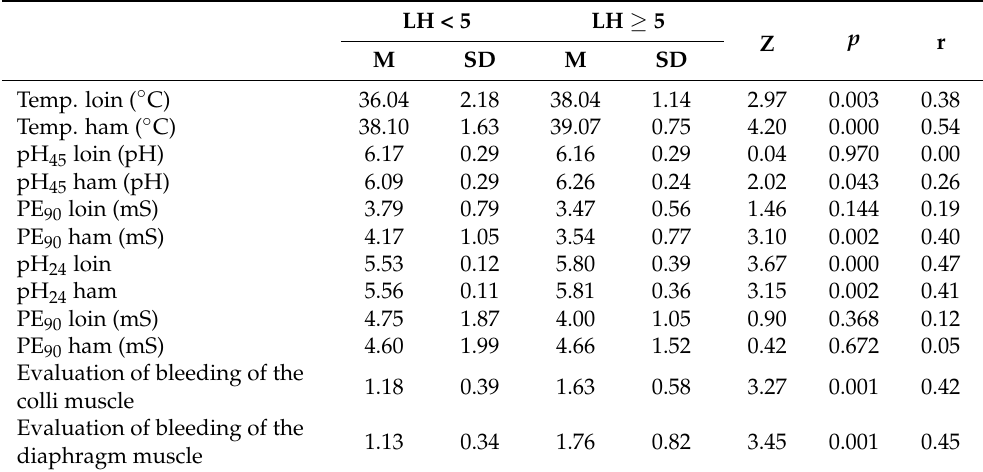
Table 6. Effect of luteinizing hormone level (mlU/mL) on selected quality parameters of gilt